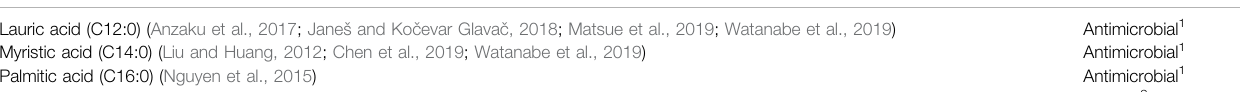
TABLE 2 | Dermal activities of selected fatty acids; 1 = functioning of the isolated fatty acid, 2 = functioning of the isolated fatty acid in a dermal formulation, - not available. Fatty acid Lauric acid (C12:0) (Anzaku et al., 2017; Jane š and Ko č evar Glava č , 2018; Matsue et al., 2019; Watanabe et al., 2019) Myristic acid (C14:0) (Liu and Huang, 2012; Chen et al., 2019; Watanabe et al., 2019) Palmitic acid (C16:0) (Nguyen et al.,